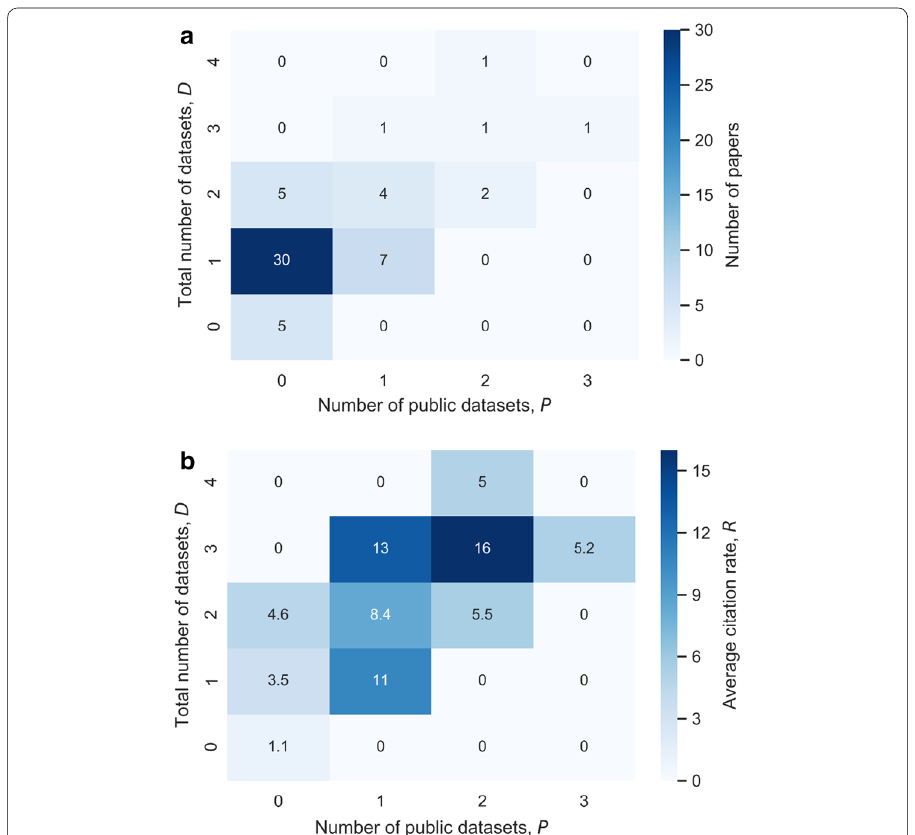
Fig. 5 Heatmap of dataset availability. The two heatmaps describing the problem of availability of the datasets used in sensor data quality literature. Both heatmaps show the number of available datasets, P against the total number of datasets, D used for method evaluation in the 57 selected papers where the number in each cell represents: a the number of papers that have used P publicly available datasets out of its D total number of datasets for method evaluation and b the average citation rate for the papers that have used P publicly available datasets out of its D total number of datasets for method